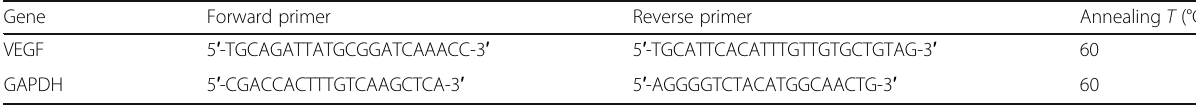
Table 2 Primers ’ sequence used for quantitative real-time RT-PCR Gene